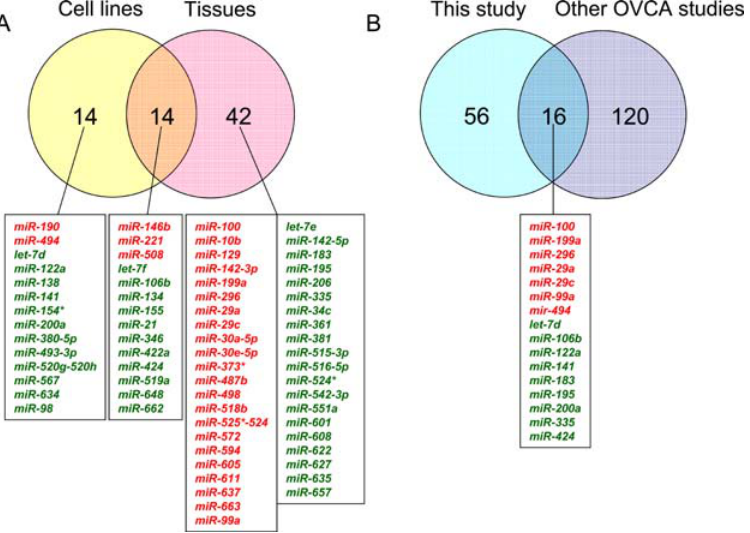
Figure 3. Comparisons of miRNA expression in ovarian tissues. (A) The Venn diagram shows the number miRNAs differentially expressed in ovarian cell lines, in ovarian cancer tissues and in both. For each category, the miRNAs elevated (indicated in red) and downregulated (indicated in green) are indicated below the diagram. (B) The Venn diagram shows the number of differentially expressed miRNAs identified in the current study and the number of miRNAs indentified in 3 previous ovarian cancer studies. The miRNAs in common are indicated below the diagram and color- coded (red: elevated; green: decreased).